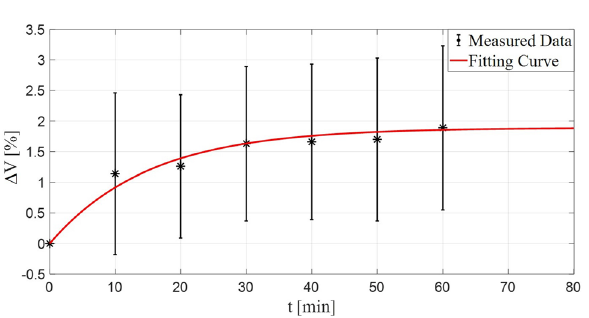
Figure 3. Post-doffing volume fluctuations plotted against time: mean and standard deviation in black, two- term exponential decay fitting curve in